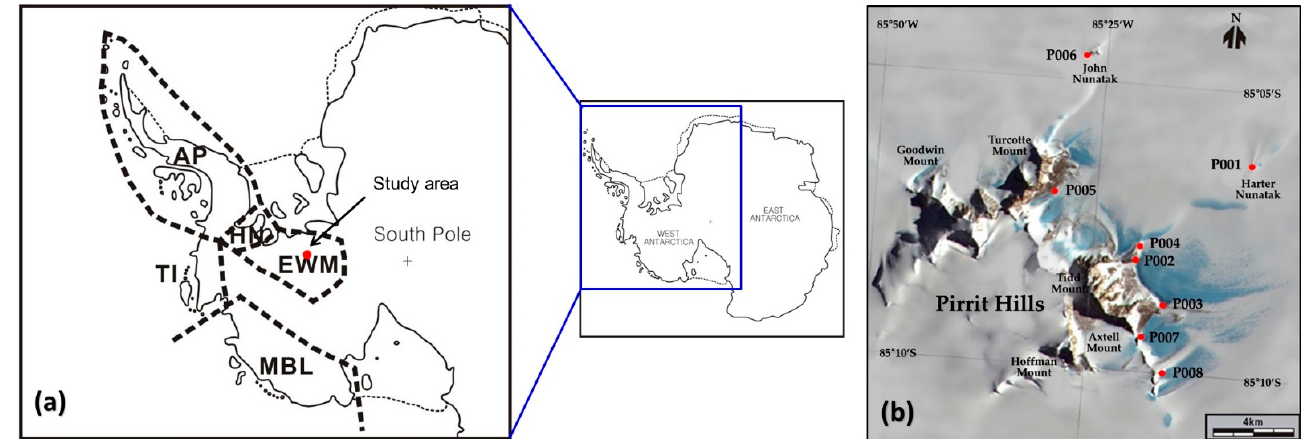
Figure 1. ( a ) Simplified location maps of the study area within West Antarctica. The major crustal blocks include the Antarctic Peninsula (AP), the Ellsworth–Whitmore Mountains (EWM), the Haag Nunataks (HN), Marie Byrd Land (MBL), and Thurston Island (TI) [30]. ( b ) Satellite image of the Pirrit Hills and sampling locations (modified from [25]).